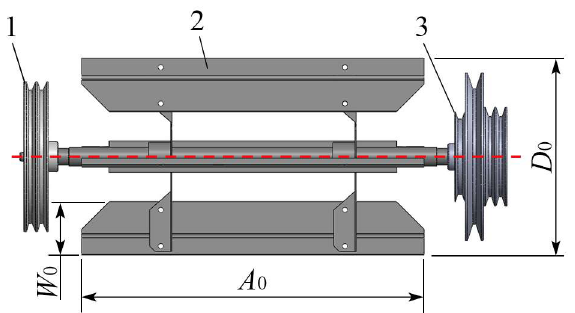
Figure 10. Schematic diagrams of the centrifugal fan structure: (1) Centrifugal fan power input pulley. (2) Fan blade. (3) Centrifugal fan power output pulley. Note: D 0 is the diameter of the centrifugal fan in mm; A 0 is the width of the centrifugal fan blade in mm; W 0 is the height of the centrifugal fan blade in mm.